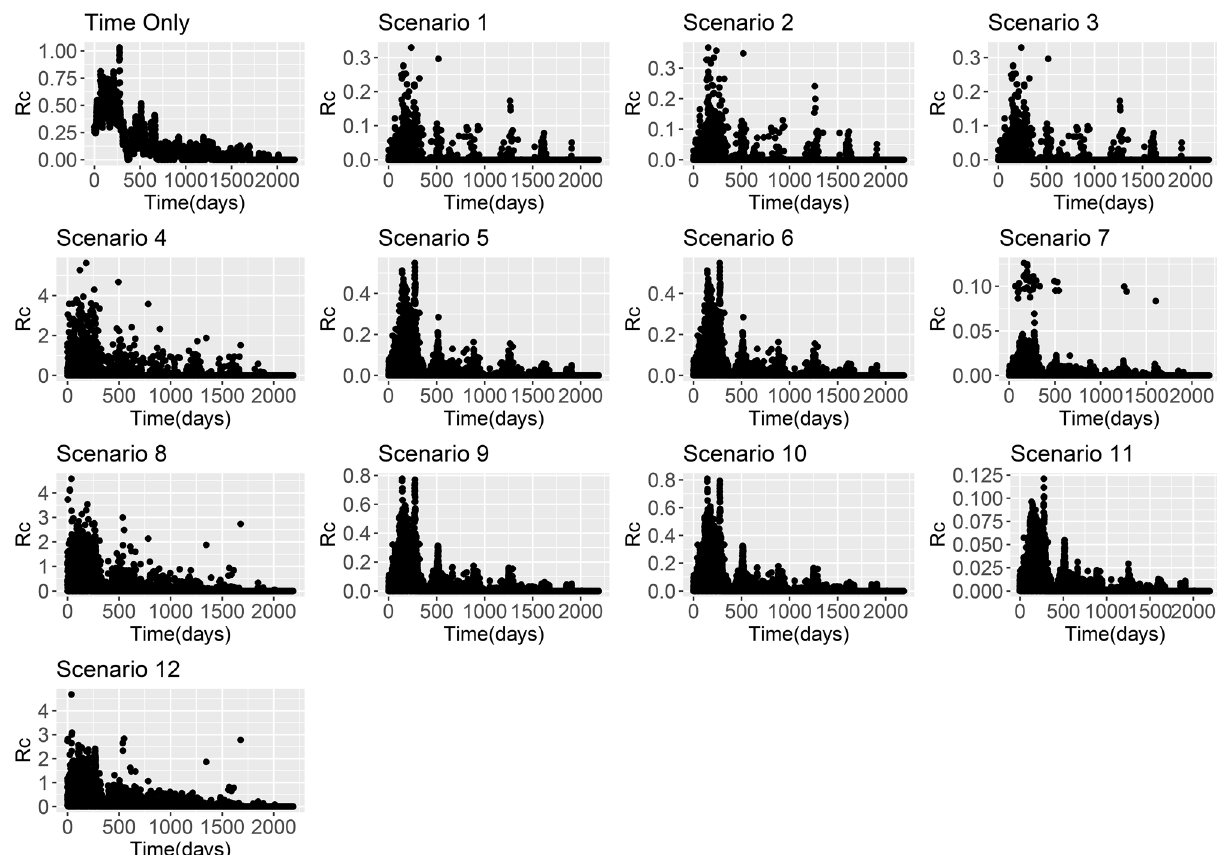
Figure 4. R c estimates from China P. vivax line list based on using the time-only scenario and Scenarios 1–12 with an exponential